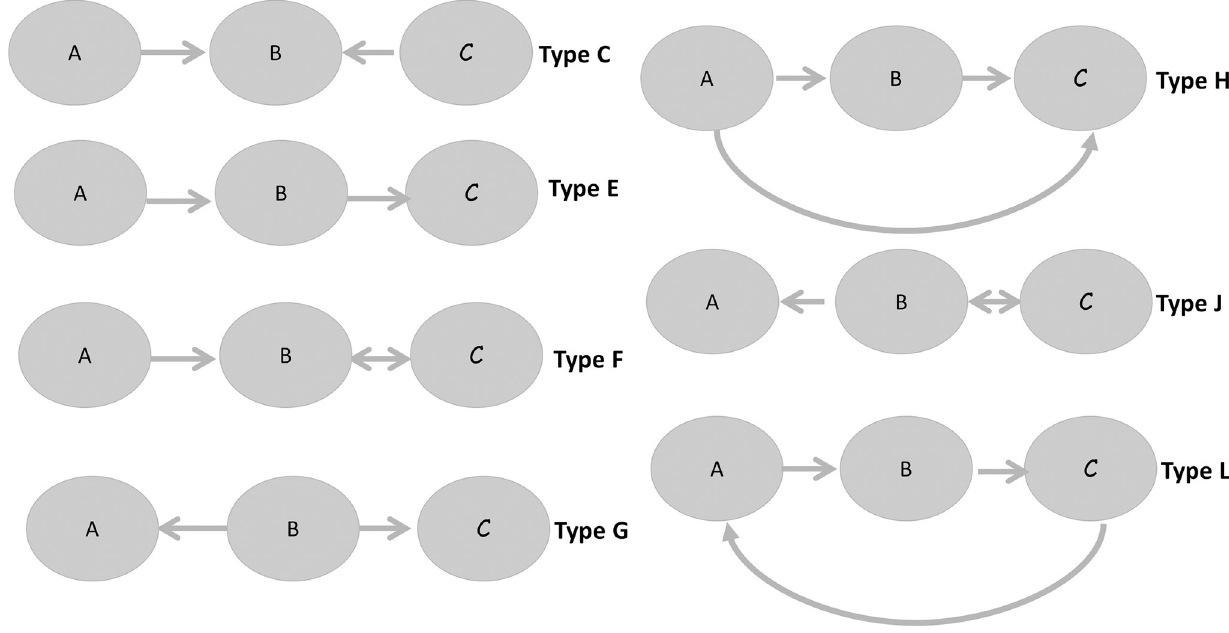
Fig 14. Number of average motifs and expected with three vertices in a random graph compared to the study plan graph.